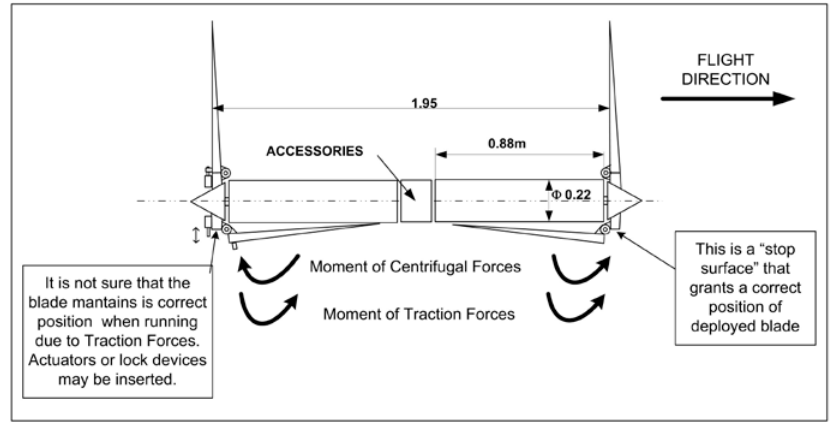
Fig. 8. Propellers with folding blades: different solutions for puller and pusher propellers